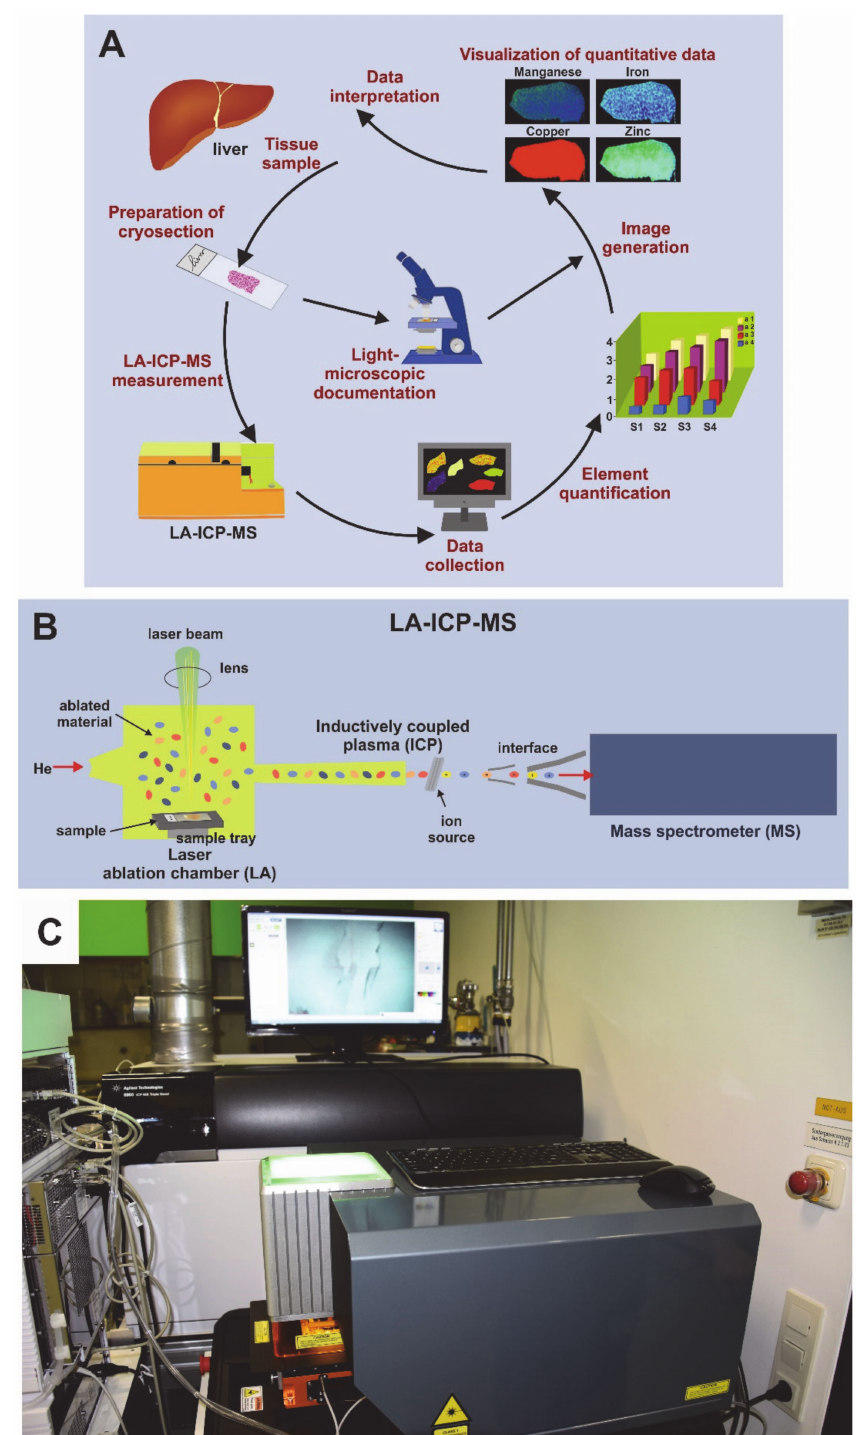
Figure 1. Laser ablation inductively-coupled mass spectrometry (LA-ICP-MS). ( A ) The workflow in LA-ICP-MS consists of di ff erent steps including the preparation and documentation of cryosection, the LA-ICP-MS measurement, data collection, element quantification, and the visualization of measured data in element maps that are useful for data interpretation. ( B ) The LA-ICP-MS device is composed of a laser chamber, an inductively coupled plasma (ICP) source, and a mass spectrometer. The individual elements (i.e., metals) are identified by their specific mass to charge (m / z) ratios. ( C ) Shown is a typical setup of an LA-ICP-MS device that was used in this